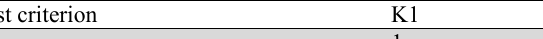
Criteria BO Vector Best criterion